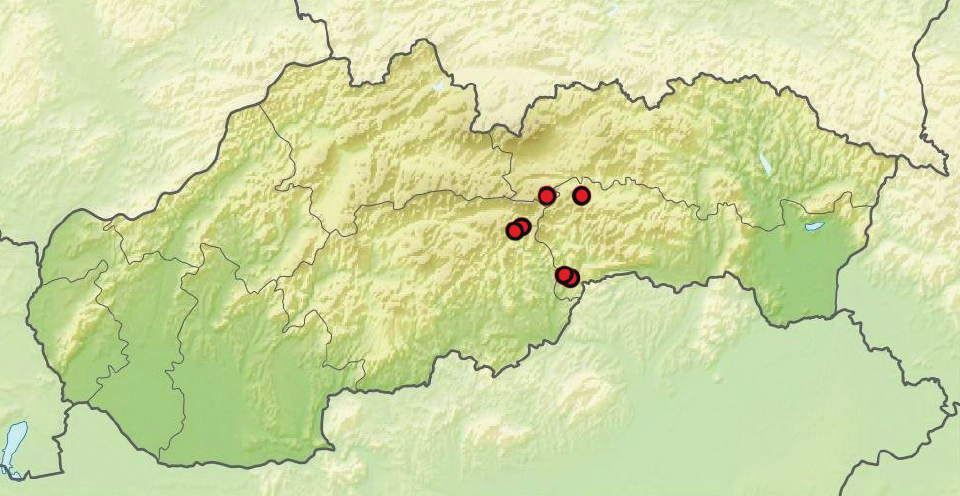
about 500 to 1050